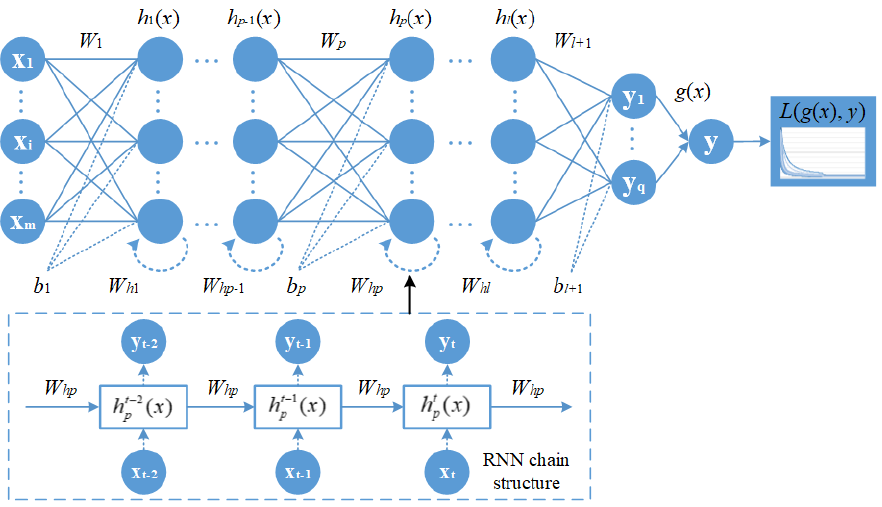
Figure 2. Structure of a typical